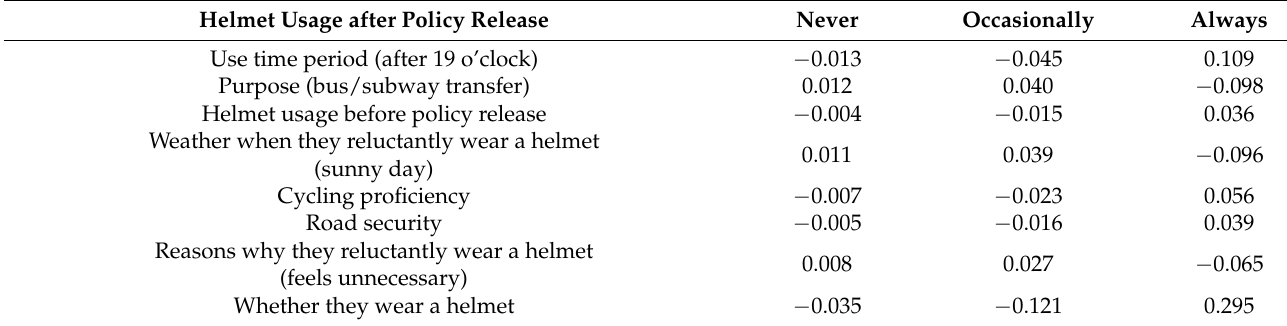
Table 7. Marginal effect of the helmet usage BOP model after policy